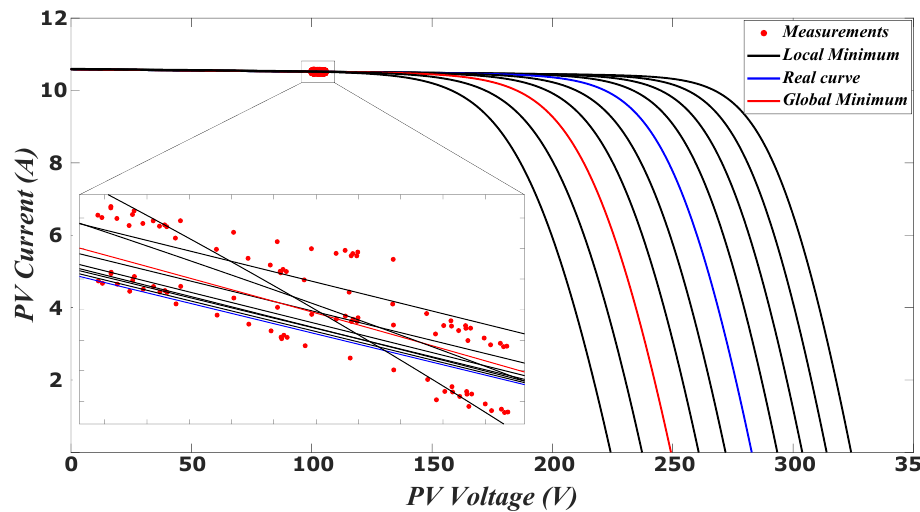
Figure 10. Local minima while operating at the left part of the I - V